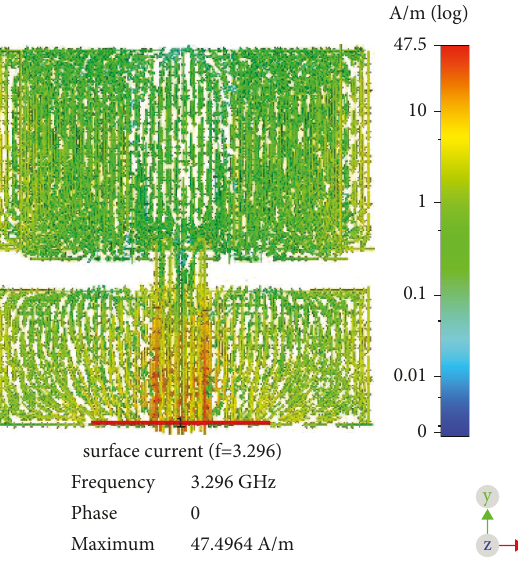
Figure 4: Surface current of the MPA at 3.296GHz.